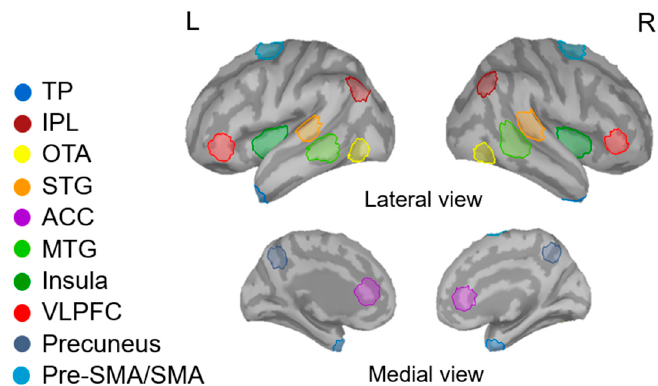
Figure 1. The identified regions of interest (ROIs) on ICBM152 brain template. TP, temporal pole; IPL, inferior parietal lobule; VLPFC, ventrolateral prefrontal cortex; STG, superior temporal gyrus; OTA, occipitotemporal area; MTG, middle temporal gyrus; Pre-SMA/SMA, pre-supplementary motor area and supplementary area; ACC, anterior cingulate cortex; R, right; L, left.